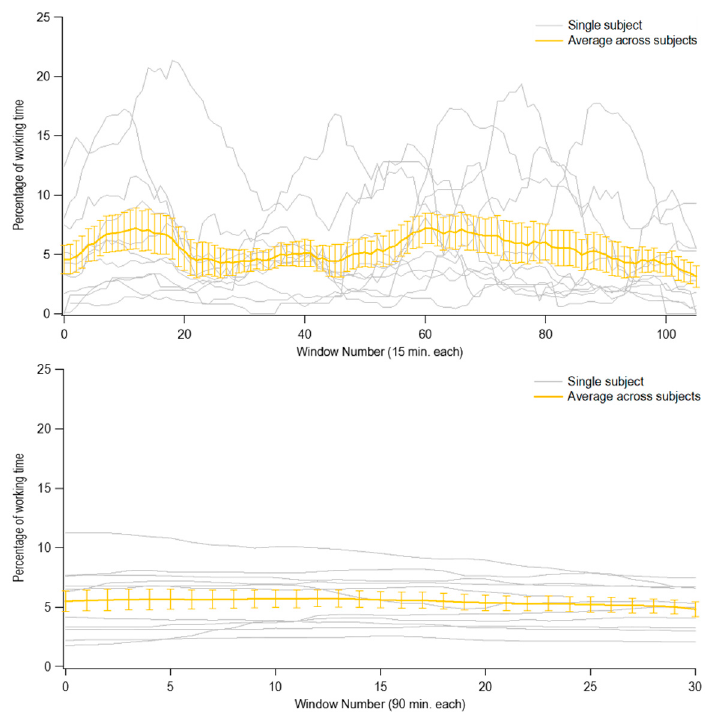
Figure 2. Examples of averages calculated across subjects using two di ff erent window durations. Grey curves represent the percentage of time in Class 1 trunk flexion for each subject, obtained with moving windows of 15 min (top) and 90 min duration (bottom), each at one-minute steps across the full two-hour sample. Yellow curves represent averages (standard errors) calculated step-by-step across subjects.